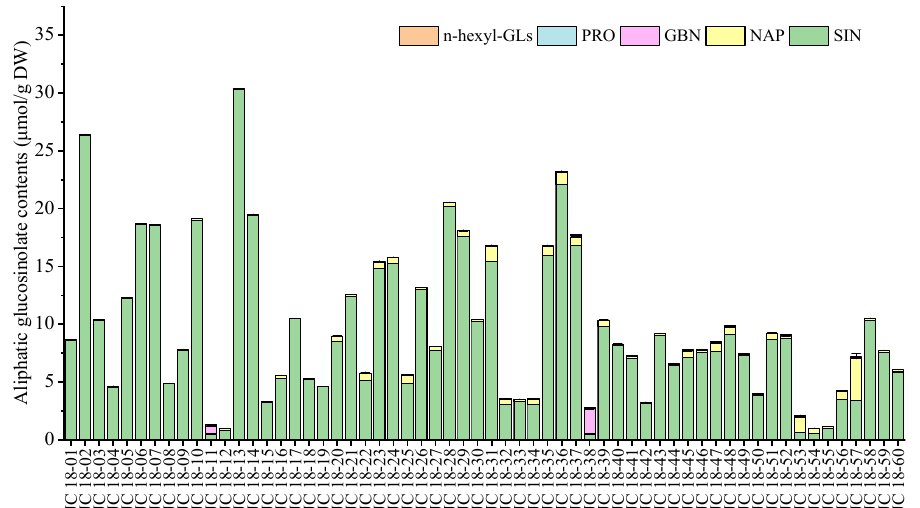
Figure 3. Variation of aliphatic glucosinolate contents in different mustard resources’ leaves. The aliphatic glucosinolates are progoitrin (PRO), sinigrin (SIN), n-hexyl-GLs, glucobrassicanapin (GBN), gluconapin (NAP), respectively.